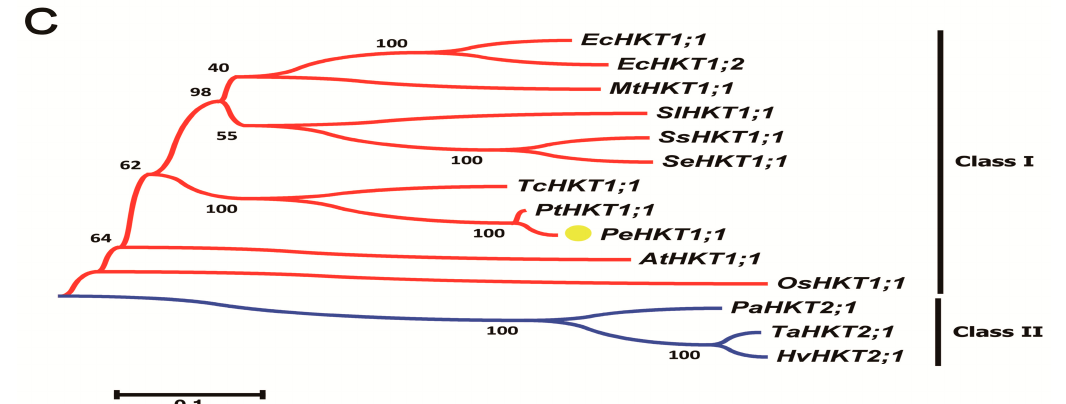
Figure 1. The transmembrane helices, alignment, and phylogenetic tree analysis of HKT (high ‑ affinity K + transporter) amino acid sequences. ( A ) The transmembrane helices of PeHKT1;1 protein were predicted by TMHMN Server v.2.0. ( B ) The four conserved selectivity ‑ filter ‑ pore regions of HKT were aligned, and highlighted in yellow, using ClustalX 2.1 software. A line above the alignment was used to mark strongly conserved positions. Three characters (“*”, “:” and “.”) were used: “*” indicates positions which have a single, fully conserved residue. “:” and “.” indicates positions that have 'strong' and 'weaker' conserved residues, respectively. ( C ) Phylogenetic tree analysis of 14 HKTs from 12 different plant species by neighbor ‑ joining method using MEGA v7.0 software with 1000 iterations bootstraps. HKT: high ‑ affinity K + transporter.